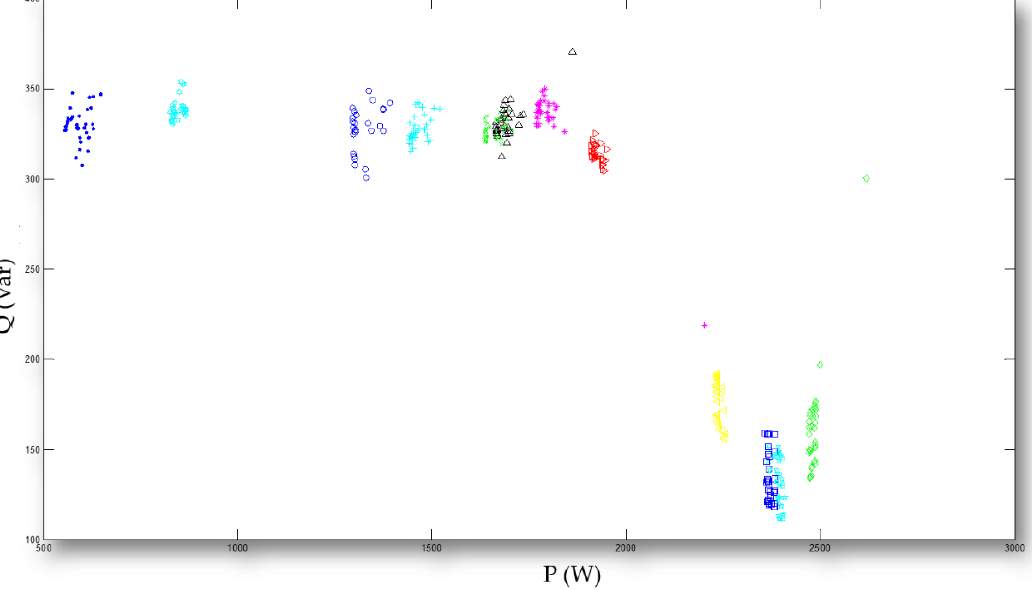
Figure 10. Feature space being of P and Q. The entire space is addressed by the configured feed-forward ANN, with / without the parallelism, in this work. A total of 12 load combinations including the scenarios in which the four electrical appliances are the mutually exclusive load combinations that need to be addressed.